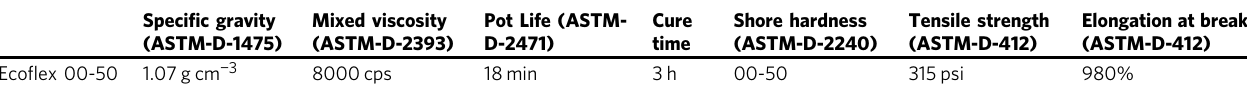
Table 1 Properties of the silicone rubber Eco fl ex 00-50 (manufacturer